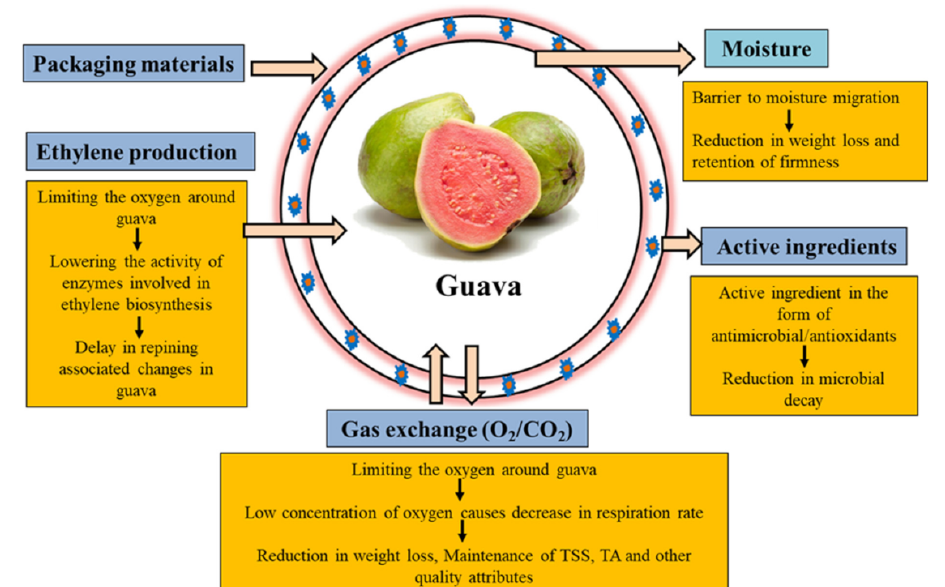
Figure 2. The figure indicating that the application packaging, i.e., edible, active, and composite, has the potential to maintain the postharvest quality attributes, such as color, aroma, firmness, and consumer acceptability by retarding the loss of moisture; reducing ethylene production; and minimizing the lipid peroxidation, respiration rate, and enzymatic and metabolism synthesis due to creation of water and gas barrier between fruit surface and